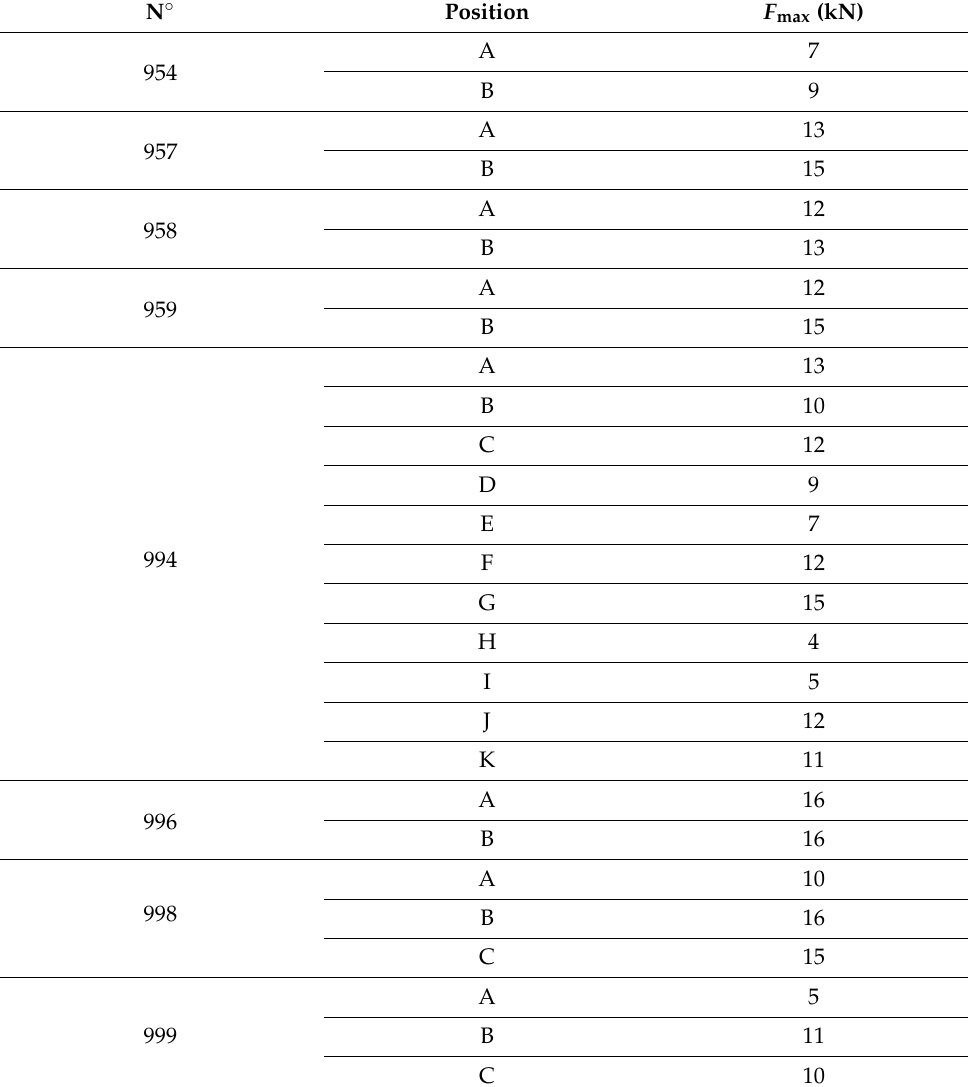
Table 4. Shear test results.